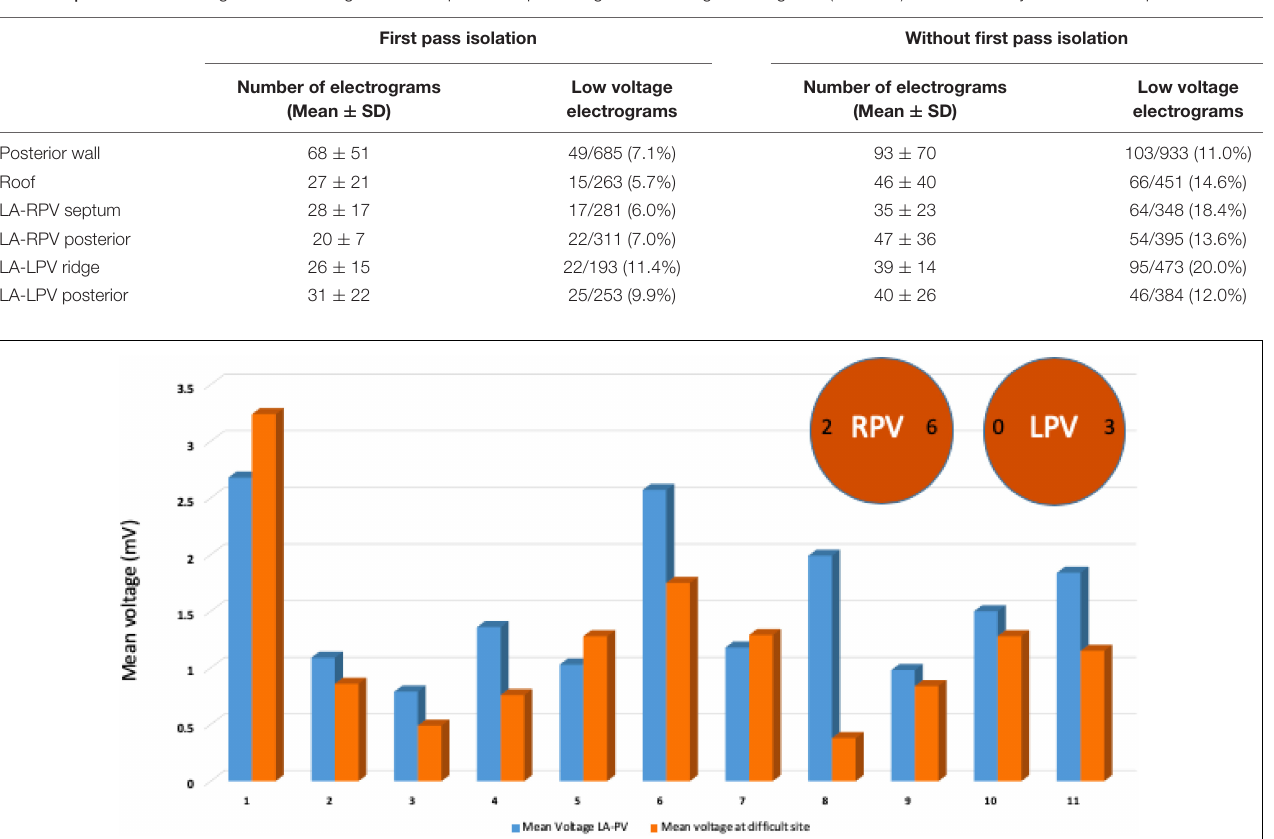
TABLE 3 | Number of electrograms in each region and comparison of percentage of low voltage electrograms ( < 0.5 mV) based on ability to achieve first pass isolation.